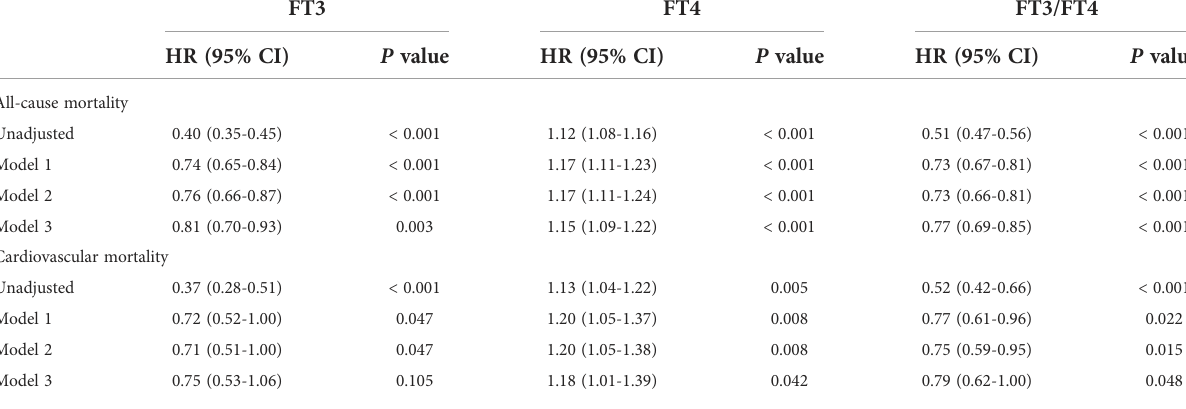
TABLE 2 Hazard Ratios of All-Cause and Cardiovascular Mortality by FT3, FT4 or FT3/FT4 Value Among Participants in NHANES III